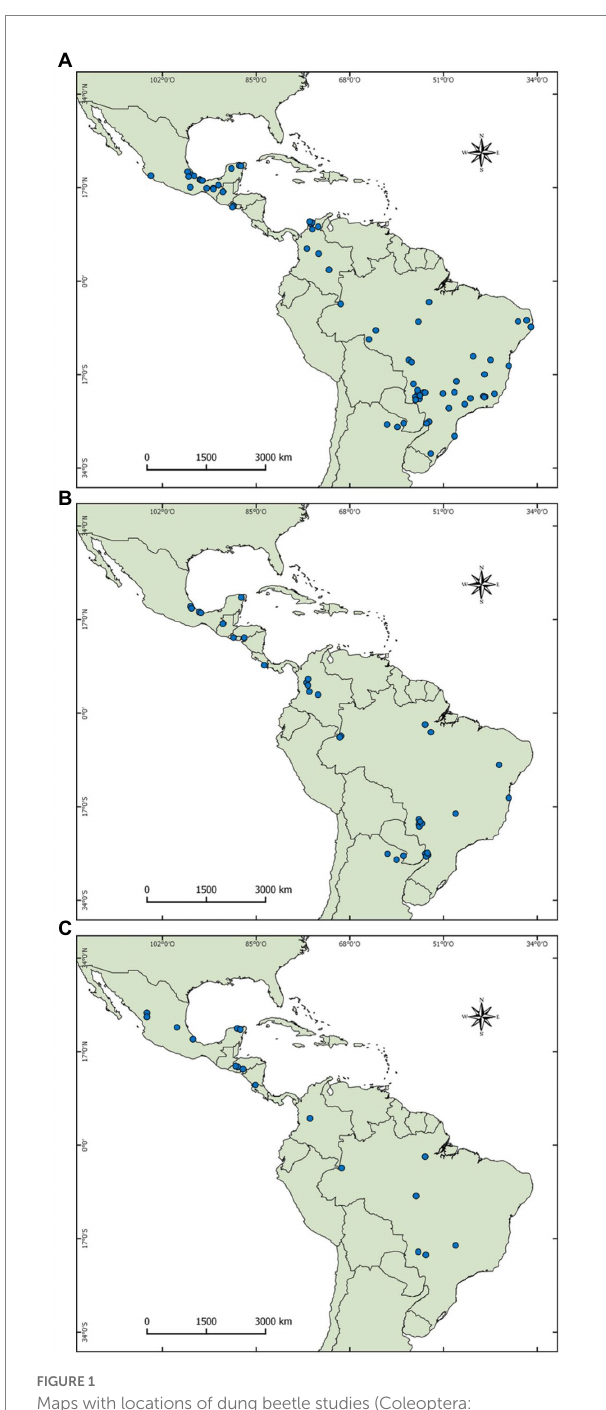
FIGURE 1 Maps with locations of dung beetle studies (Coleoptera: Scarabaeidae) in grazing environments included in the analytical review. (A) Taxonomic diversity studies, (B) functional diversity studies, (C) ecological functions